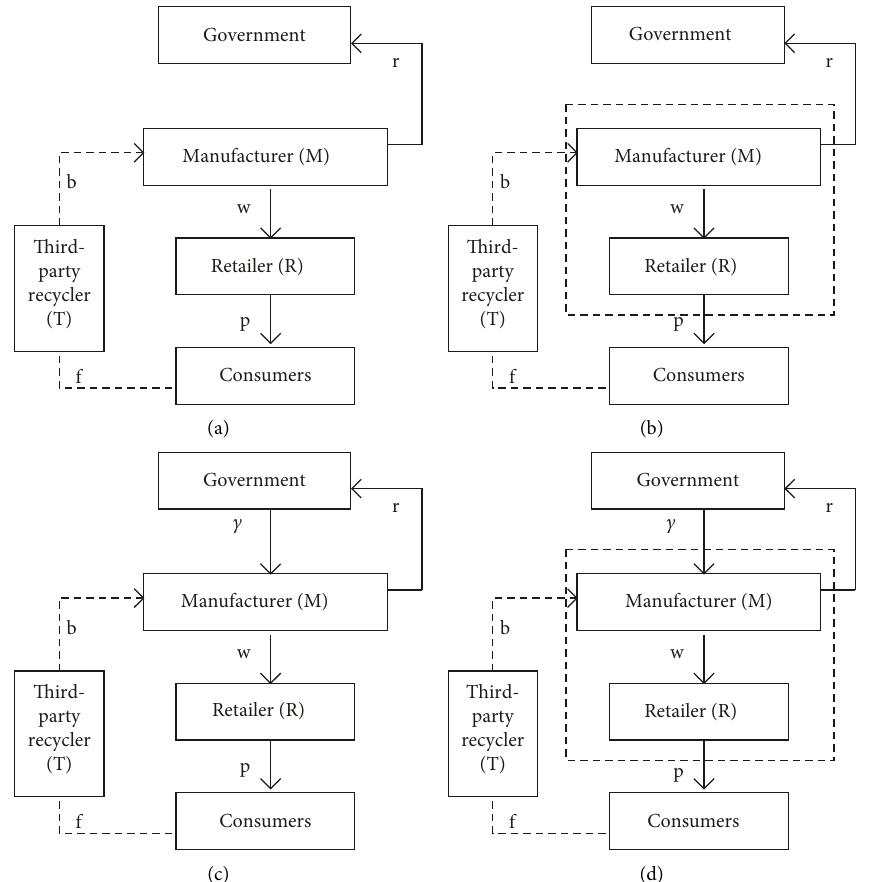
Figure 1: Closed-loop supply chain models with government involvement (a) DD model (b) DA model (c) SD model (d) SA